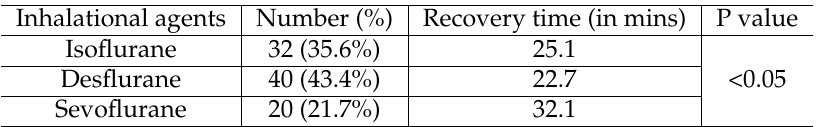
Table 2. Recovery time amongst inhalational agents